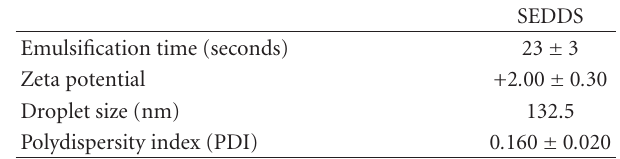
Table 1: Reconstitution properties of the SEDDS.